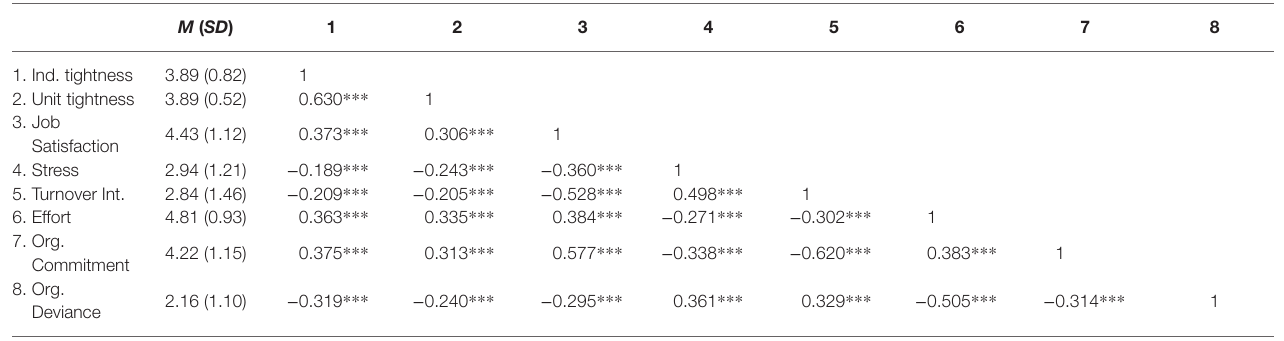
N = 417; Team N = 57; Ind. tightness = perceived cultural tightness at the individual level; Unit tightness = perceived cultural tightness at the unit level; Stress, perceived stress; Turnover Int., turnover intentions; Effort, effort investment; Org. Commitment, organizational commitment; and Org. Deviance, organizational deviance. *** p < 0.001.